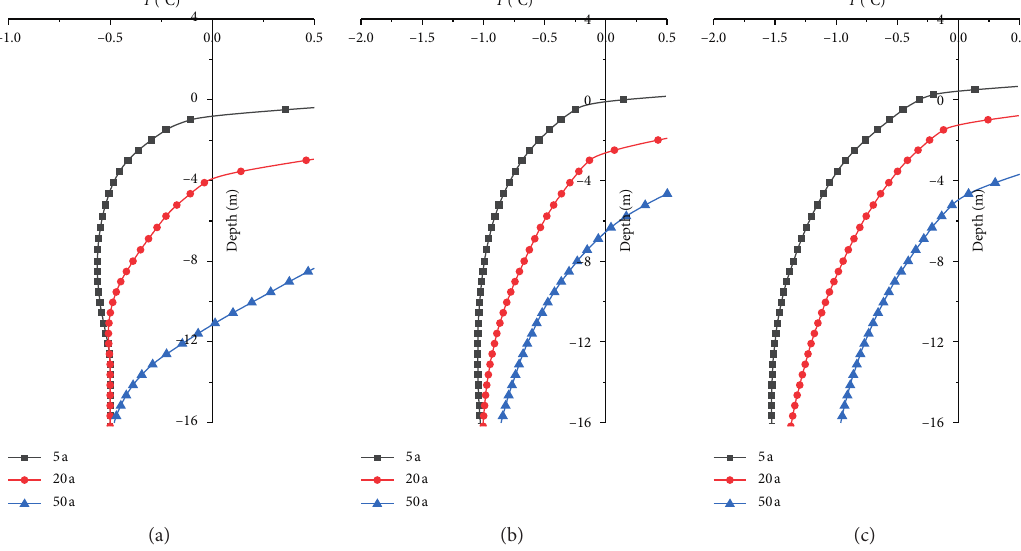
Figure 9: Variation in soil temperature beneath the CE in October of the 5th, 20th, and 50th years under different mean annual ground temperatures: (a) − 0.5 ° C, (b) − 1.0 ° C, and (c) − 1.5 °